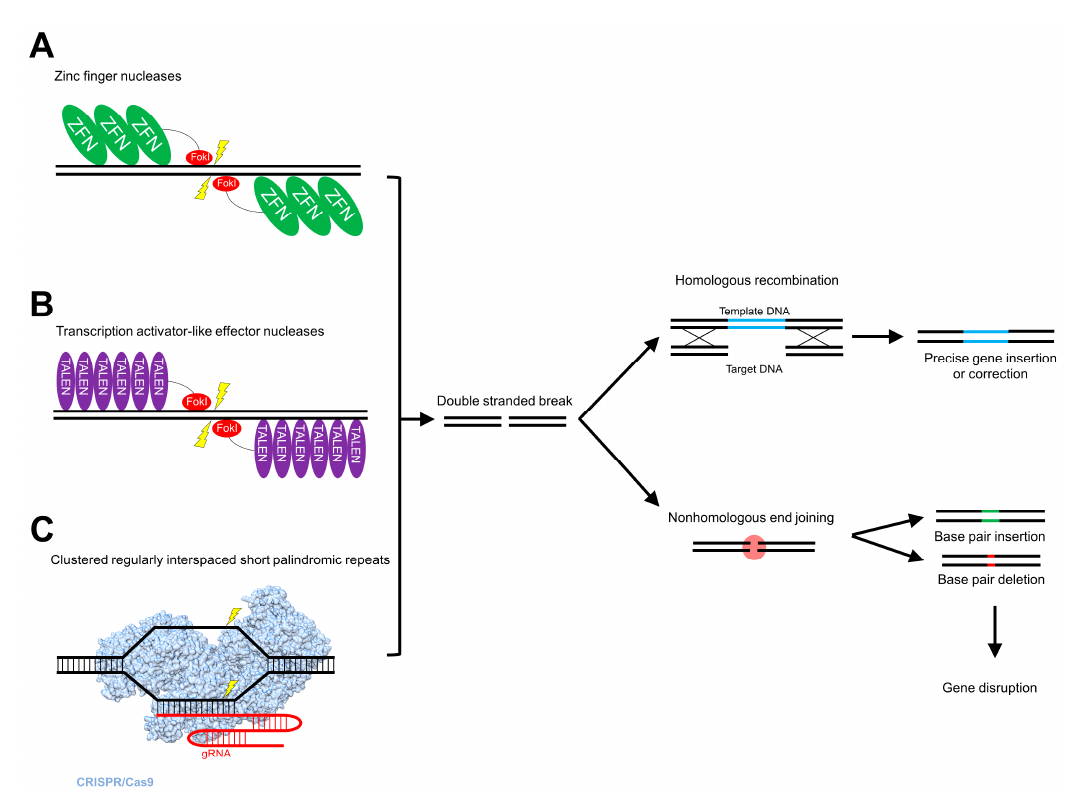
Figure 2. Recombinantly engineered nucleases utilize endogenous DNA repair mechanisms for genome editing. ( A ) Zinc finger nucleases (ZFNs), covalently bound to the FokI restriction enzyme nuclease domain, dimerize and generate double-stranded breaks (DSBs) in target DNA. ( B ) Similarly, transcription activator-like effector nucleases (TALENs) bind to target DNA, and the FokI nuclease domain generates DSBs. ( C ) Clustered regularly interspaced short palindromic repeats (CRISPR) bound to CRISPR-associated protein 9 (Cas9) contain a guide RNA (gRNA) (PDB ID: 5U0A) [165]. Through hybridization of the gRNA to the target region, DSBs are generated at specific sites, with subsequent insertion of the donor DNA. DSBs are a substrate for two endogenous DNA repair mechanisms; homologous recombination (HR) and nonhomologous end joining (NHEJ). HR results in the integration of donor DNA with precision and fidelity, whereas NHEJ results in insertions and deletions at the DSB cleavage site of varying base pair lengths, thus resulting in gene disruption, without the insertion of donor DNA. The inability to favor one mechanism over another results in off-target effects and unintended mutations, insertions and deletions inherent to these endogenous mechanisms.